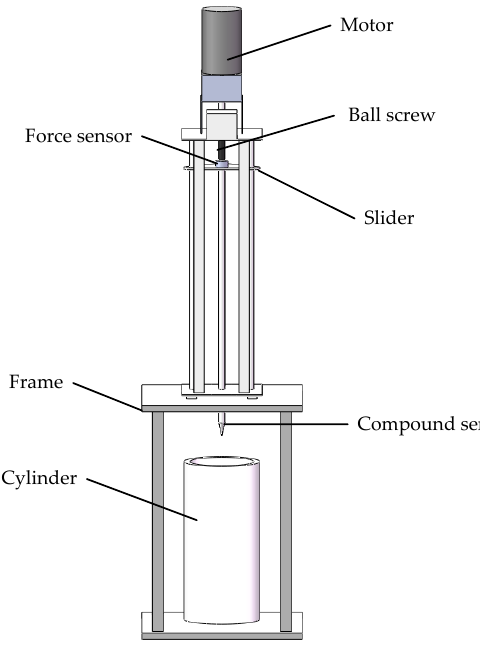
Figure 8. Diagram of the validation system.